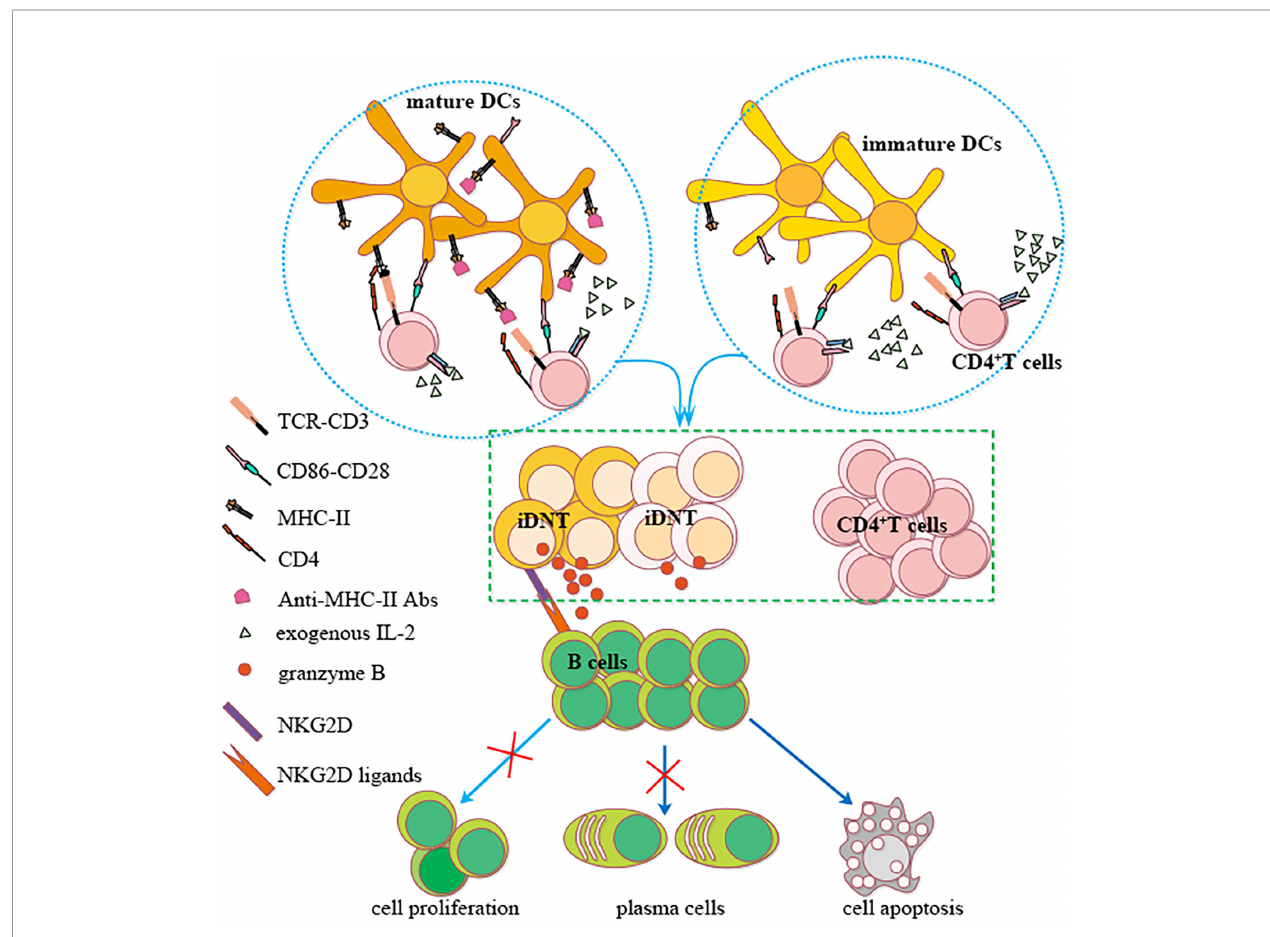
FIGURE 6 | A possible mechanism of nonregulatory CD4 + T cells induction into iDNT cells and NKG2D enhancement of iDNT cells regulation of B cells. Nonregulatory CD4 + T cells may be induced to become regulatory iDNT cells in vitro . IL-2 promotes the induction process, and MHC-II expressed on bone marrow DCs impedes this process. These iDNT cells were activated after successful induction, which promoted B cell apoptosis and inhibited B cell proliferation and plasma cell formation. A small portion of iDNT cells express NKG2D, which induces the release of granzyme B to enhance iDNT cell-mediated regulation of B cell functions via the NKG2D ligand